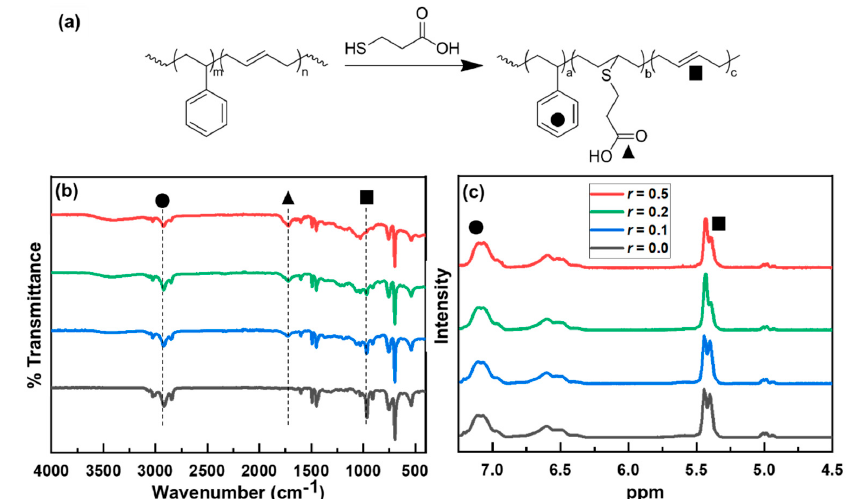
Figure 1. ( a ) Reaction scheme for the selective PB modification for PS 34k - b -PB 25k particles by mercaptopropionic acid (MPA); ( b ) FT-IR spectra of particles for r = 0.0, 0.1, 0.2, 0.5; ( c ) 1 H NMR spectra of pristine PS 34k - b -PB 25k particles ( r = 0, black) and MPA-modified particles with a varying MPA feed ratio ( r = 0.1, blue; r = 0.2, green; r = 0.5, red). The reaction time was fixed to 1